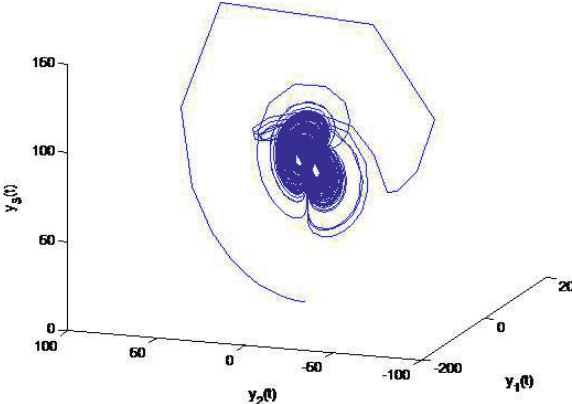
Fig. 2: Phase portrait of the Qi system in y 1 − y 2 − y 3 space for the order of derivative q =